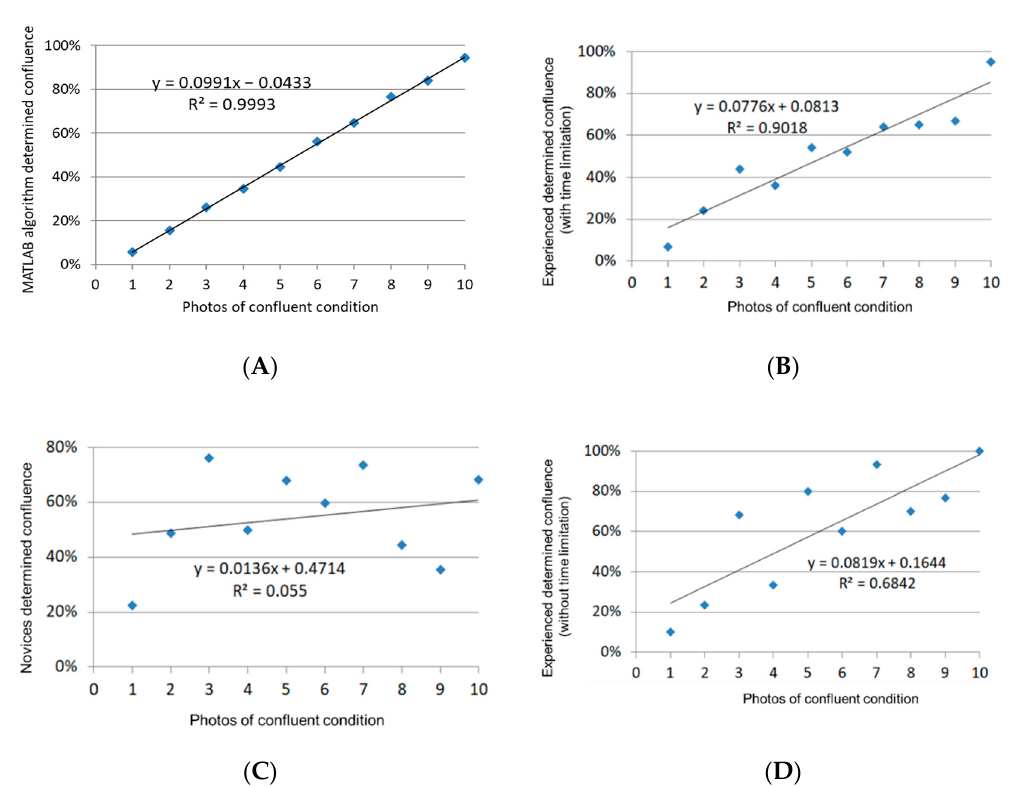
Figure 5. The measurement of cell confluence performed using various approaches. Each datum point represents a mean of the cell confluence determined by ( A ) the algorithm; ( B ) novice students (n = 6); ( C ) experienced researchers (n = 6) with a time limitation (1 min); or ( D ) experienced researchers without a time limitation. Cell photos were marked from 1 to 10, representing the increased cell number in the cell dishes. Five photos of each confluence condition were used for the evaluation.